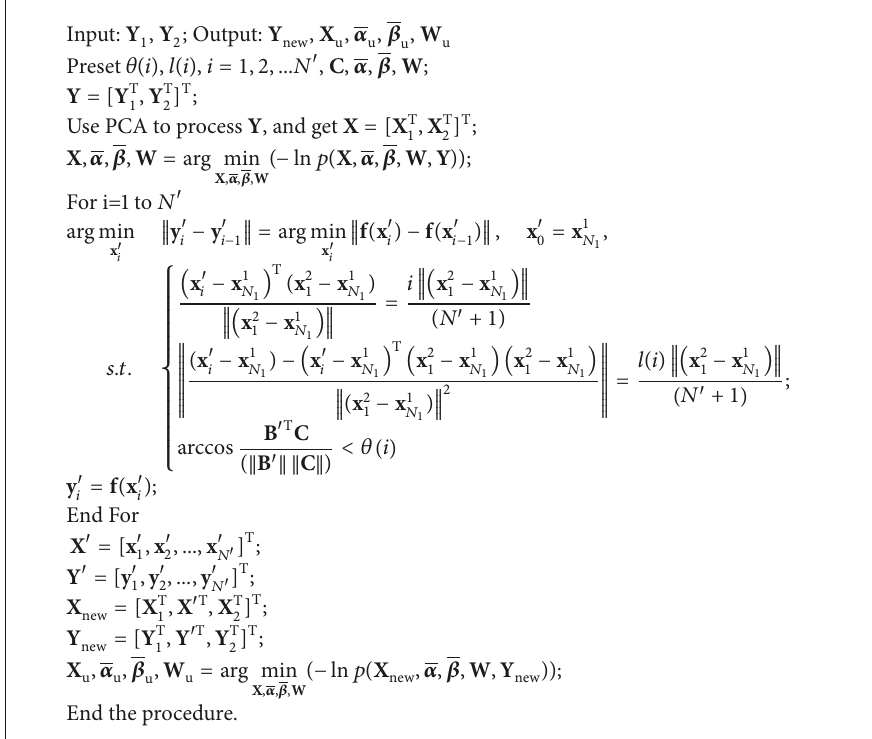
Algorithm 1: The brief procedure of